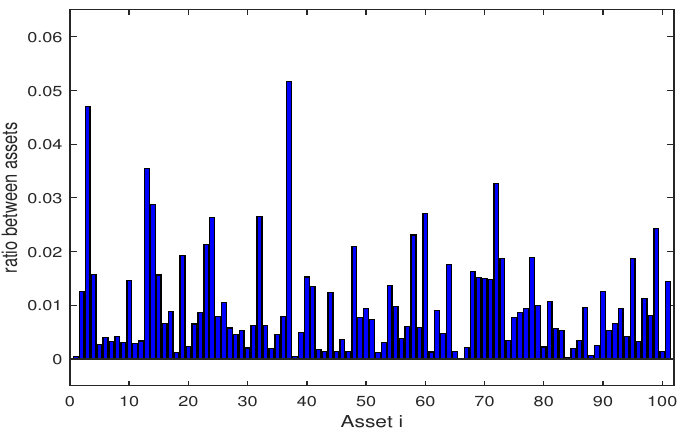
Figure 8. The specific asset structure of optimal portfolio in X ∈ [ 0,0.1 ] of model (30) for 101 assets.